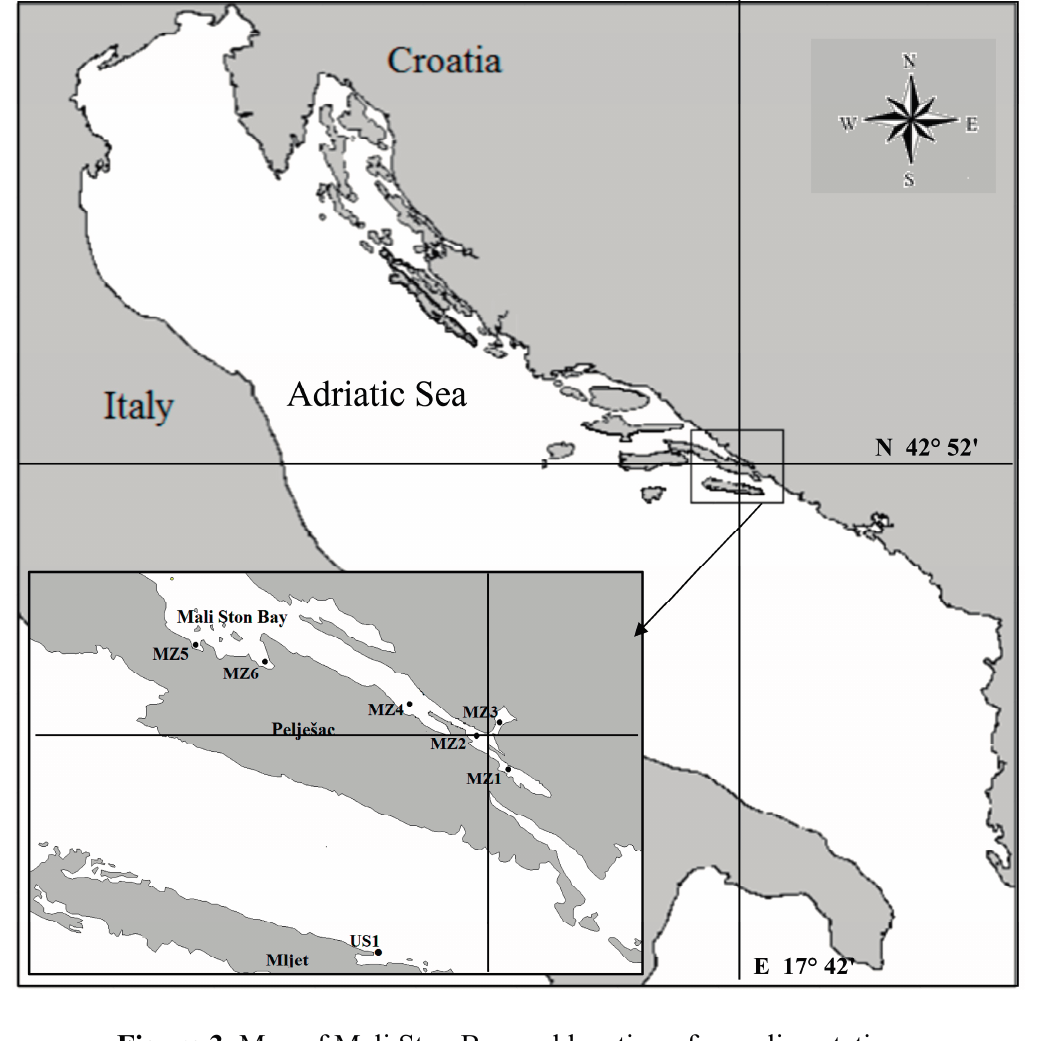
Figure 3. Map of Mali Ston Bay and location of sampling